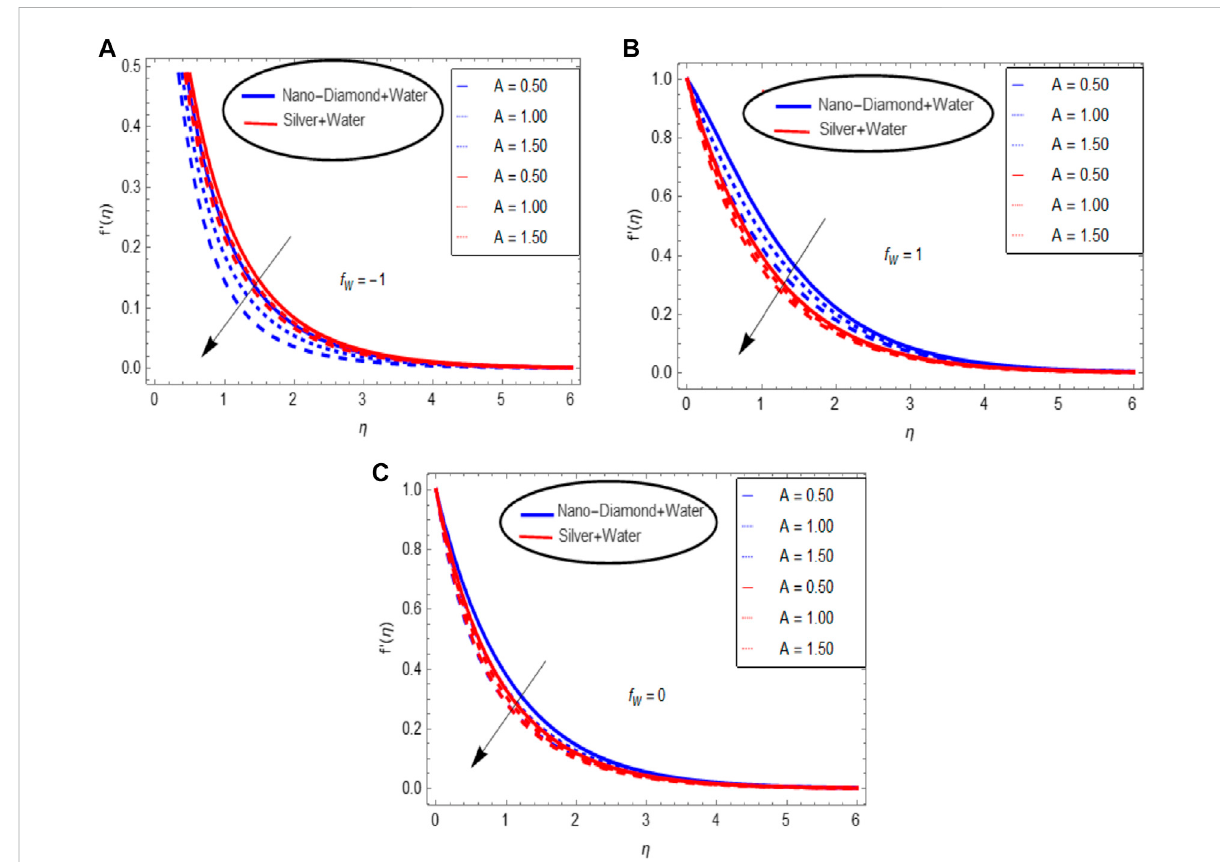
FIGURE 3 In fl uence of the unsteadiness parameter in the presence of (A) suction, (B) injection, and (C) without suction/injection on the velocity pro fi